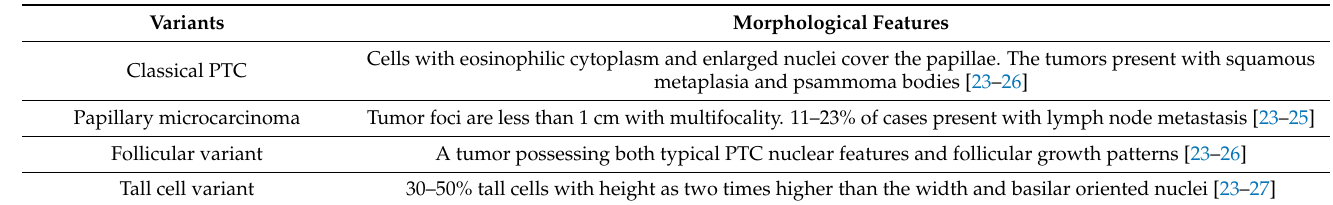
Table 1. Variants of papillary thyroid